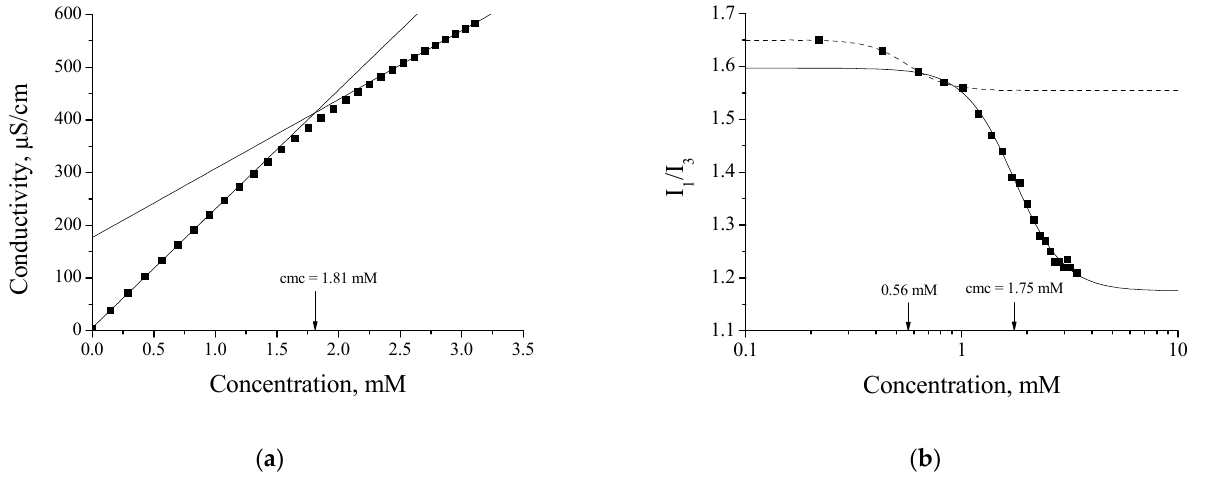
Figure 1. ( a ) Specific conductivity (with linearly fitted dependences before and after cmc) and ( b ) I 1 /I 3 ratio (with sigmoidal data fitting for the pre-micellar region – dotted line and for determining the real cmc – solid line) vs. concentration of BIBr recorded at room temperature.